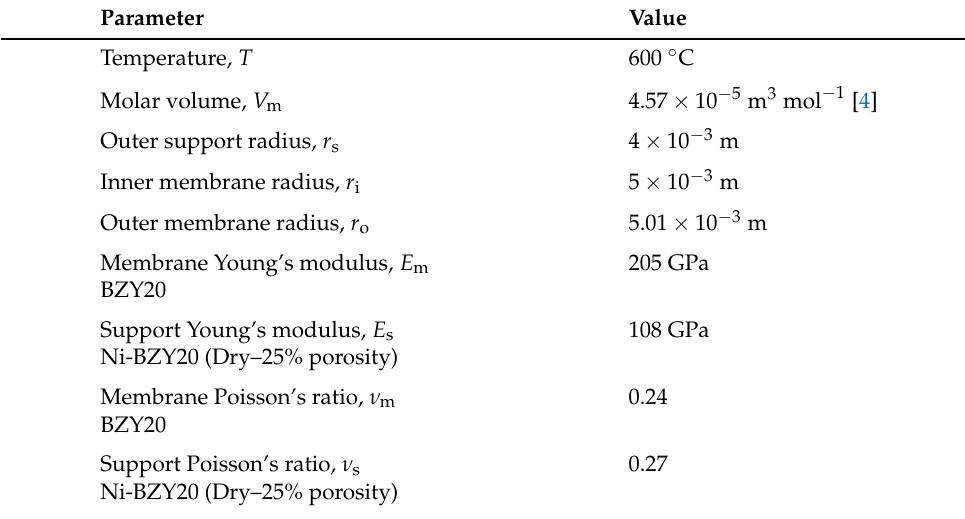
Table 3. Thermo-mechanical and geometrical properties of